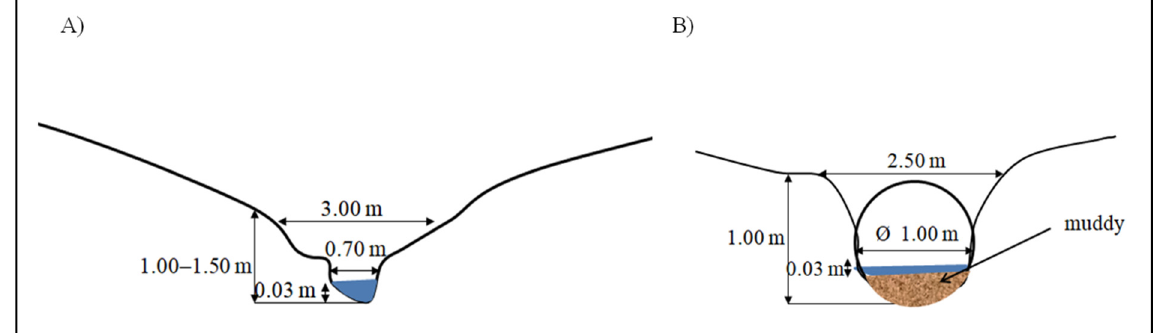
Figure 7. Bed dimensions: ( A )—semi-natural section; ( B )—urbanised section. The HDS index indicates the hydromorphological diversity of the stream. The HDS